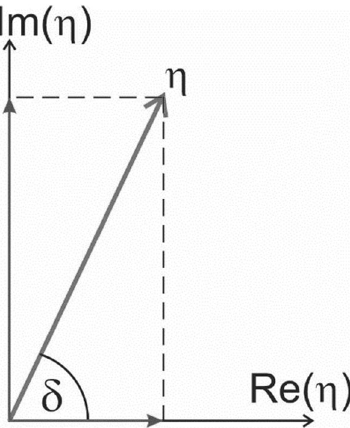
Fig. 13 Geometrical interpretation of phase shift or loss angle, δ, and real and imaginary part of complex viscosity,